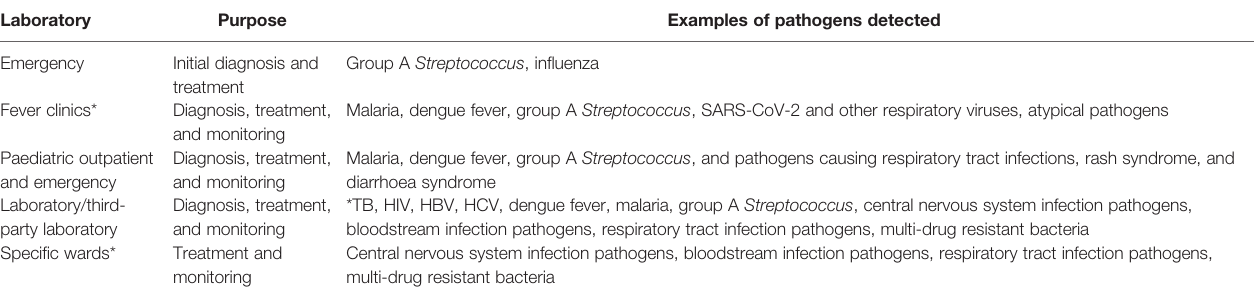
TABLE 1 | Application scenarios of pathogen nucleic acid